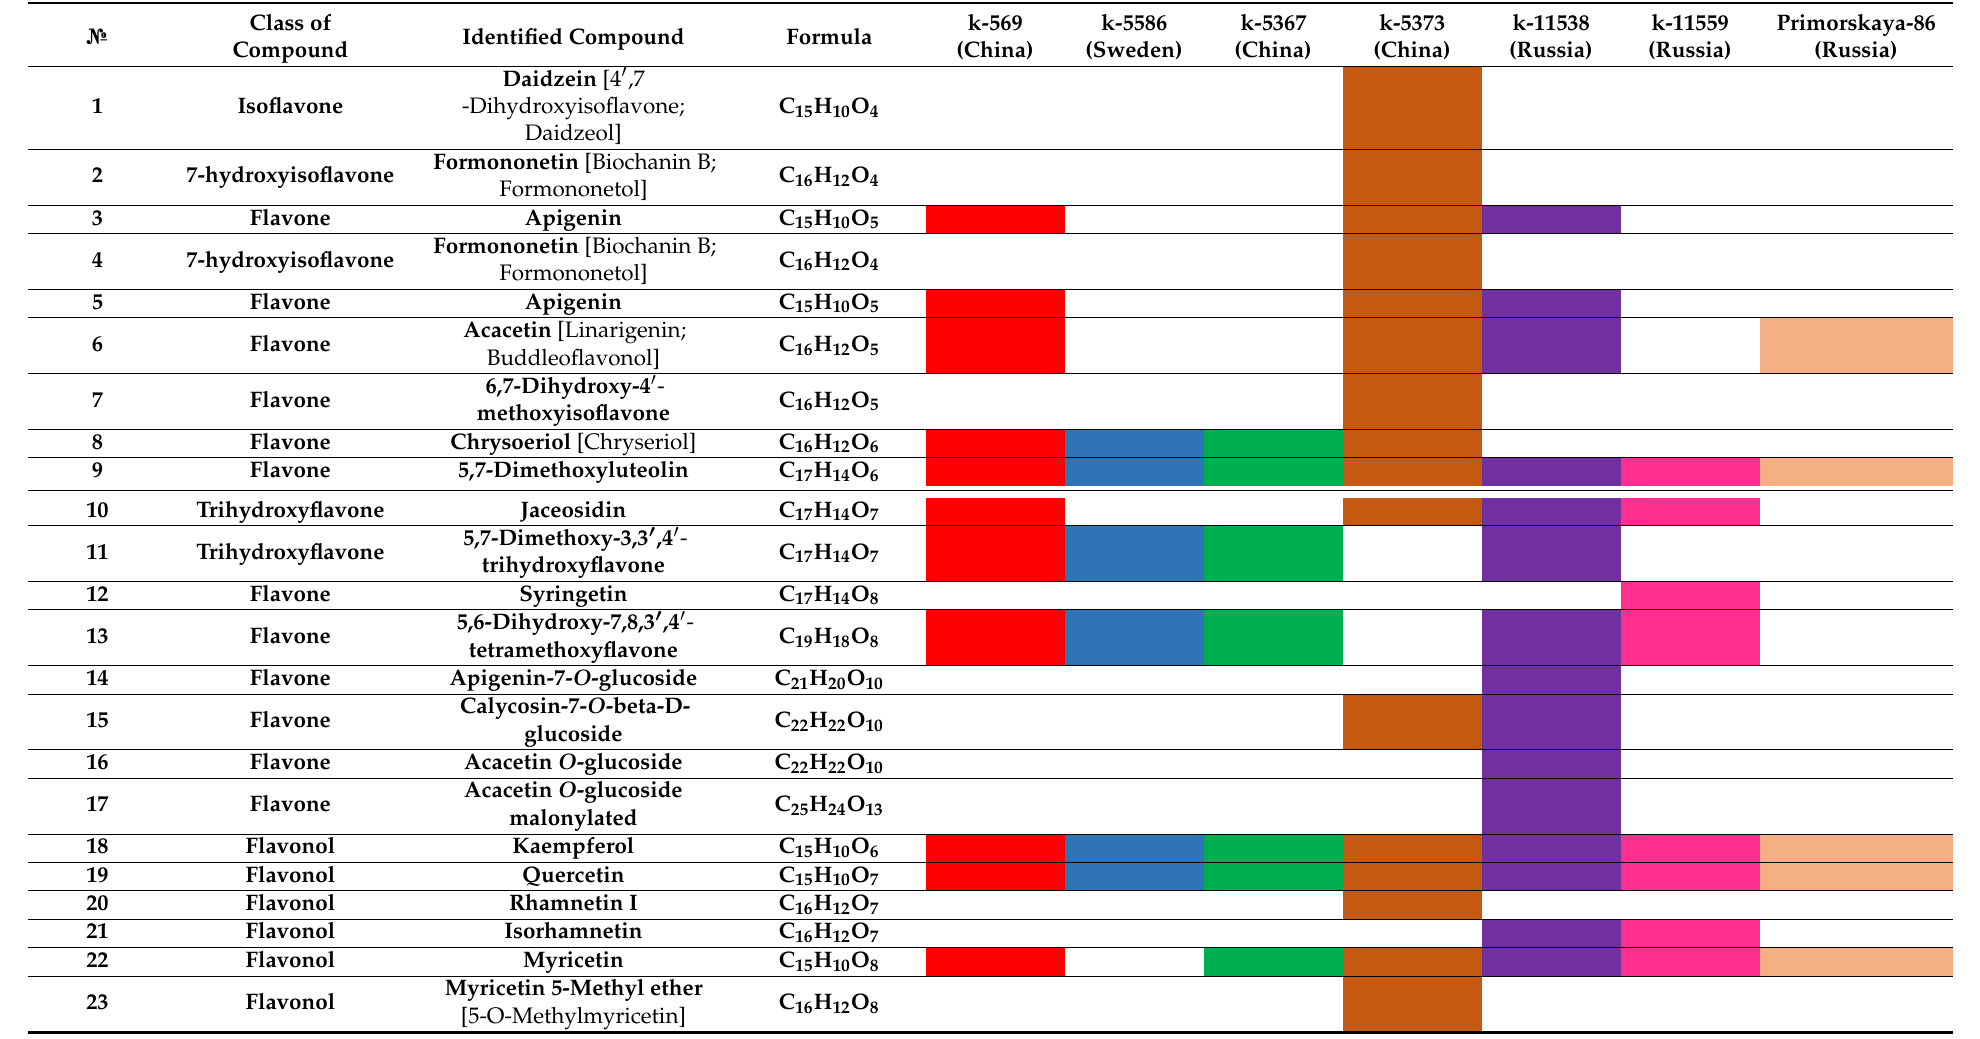
Table 2. Polyphenolic compounds identified in seven varieties of